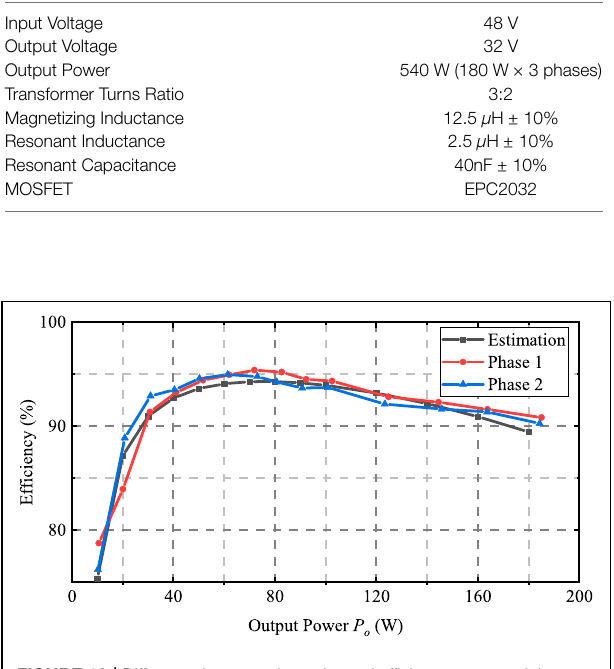
FIGURE 10 | Difference between the estimated efficiency curve and the practical efficiency curves.